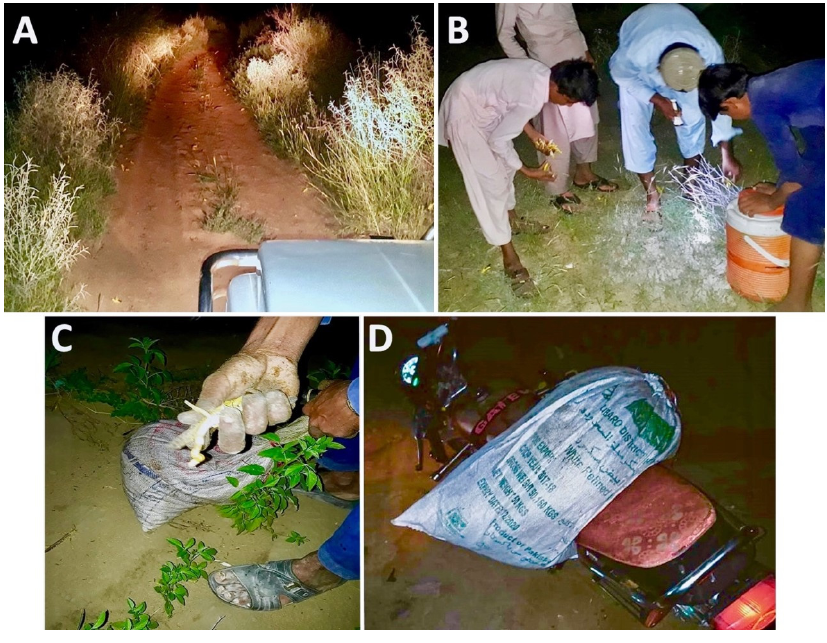
Figure 2. Collecting desert locusts at night in a field of crops: ( A ) vehicle headlight used as a light trap, ( B ) hand torch for collecting locusts and container for storage, ( C ) polypropylene bag for locusts, ( D ) polypropylene bag containing locusts ready for delivery. Photos by Ahmed Ali Samejo, Santosh Kumar, and Samiullah Soomro.